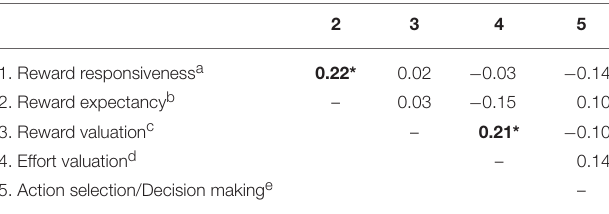
TABLE 4 | Inter-task